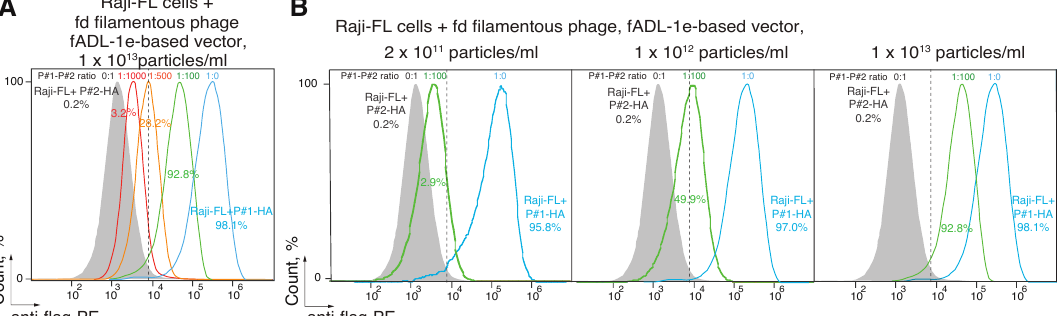
Figure 3. Estimation of the minimal concentration of the ligand-carrying bacteriophage su ffi cient for the successful CyCLOPS technique. Ligand–receptor interaction was studied by the flow cytometry using Raji cells expressing a membrane-tethered BCR in a single-chain format (Raji-FL cells) and filamentous bacteriophages carrying its peptide ligand (P#1). Raji-FL cells were incubated with filamentous phages exposing P#1-peptide, irrelevant P#2 peptide, or a mixture of phages carrying P#1 and P#2 peptides in ratios of 1:1000, 1:500, and 1:100 at a final concentration of 1 × 10 13 ( A ) or in a ratio of 1:100 and concentration of 2 × 10 11 –1 × 10 13 phage particles per mL ( B ). Fluorescence signals are plotted on the x -axis, and the percentage of the recorded events is on the y -axis. Each histogram shows the cut-o ff gate at a false-positive signal level of